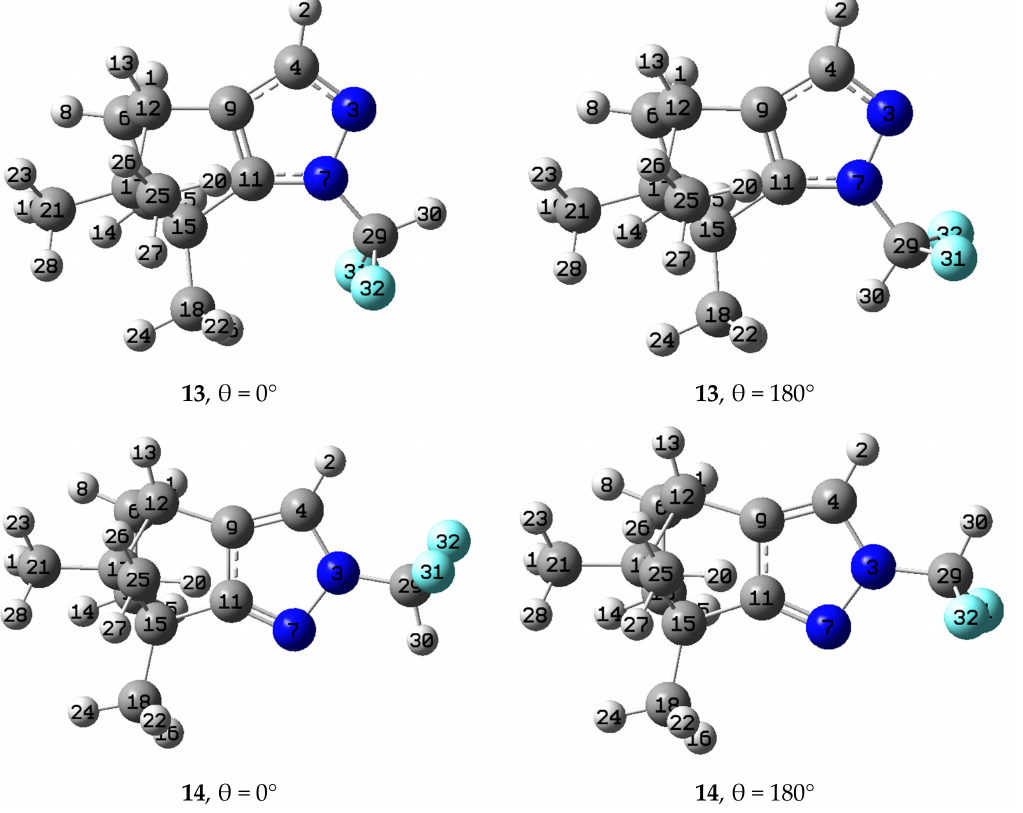
Figure 4. The four